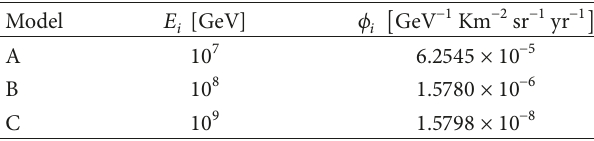
Table 2: Values of the normalization constants 𝜙 𝑖 and pivot energies for the different PeV neutrino models presented in [9].